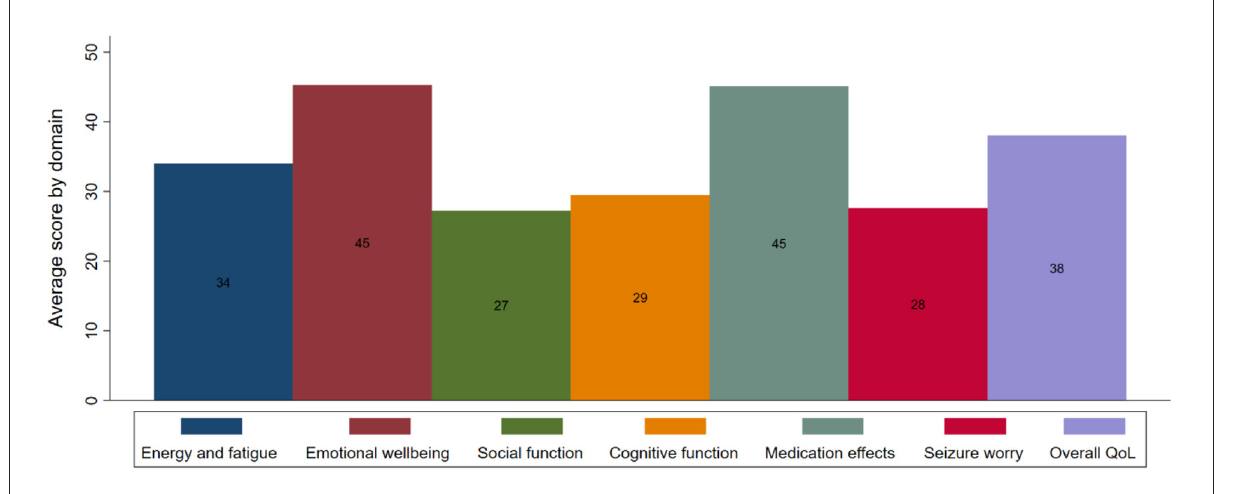
FIGURE3 Average QOLIE-31-P domain scores (a higher score reflects a better quality of